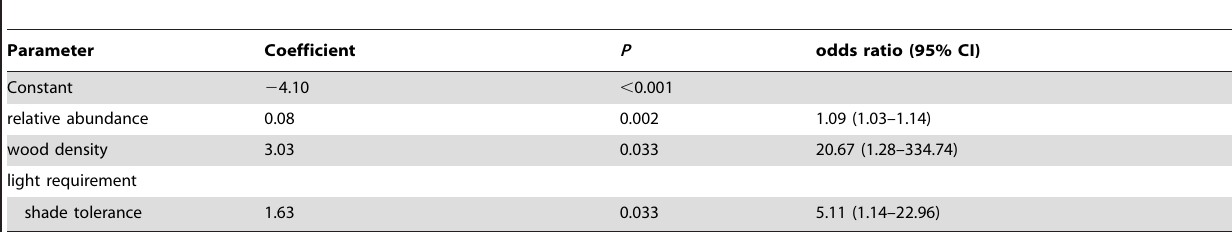
Table 5. Final multiple logistic regression model explaining the establishment of mixed-forest tree species in the monodominant Gilbertiodendron